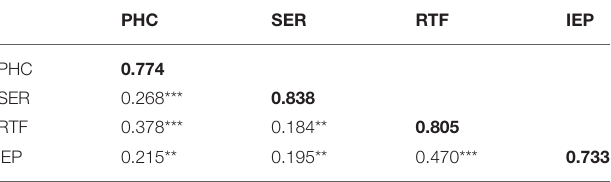
TABLE 4 | Discriminative